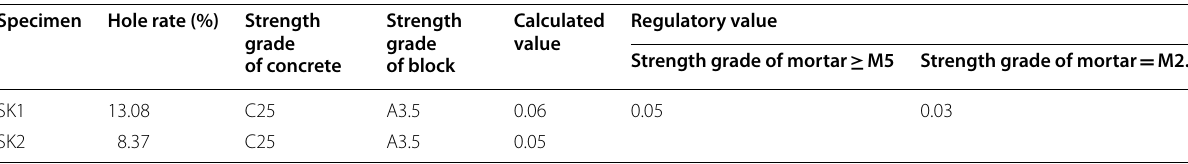
Table 9 Comparison of recommended values and regulatory values.